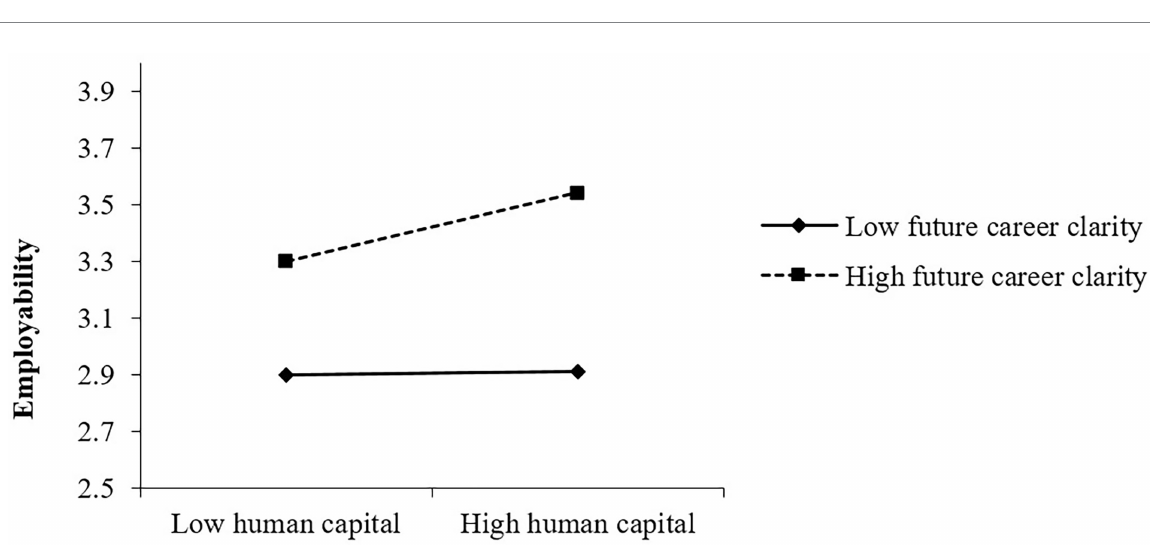
FIGURE 3 The moderating effect of future career clarity on human capital and